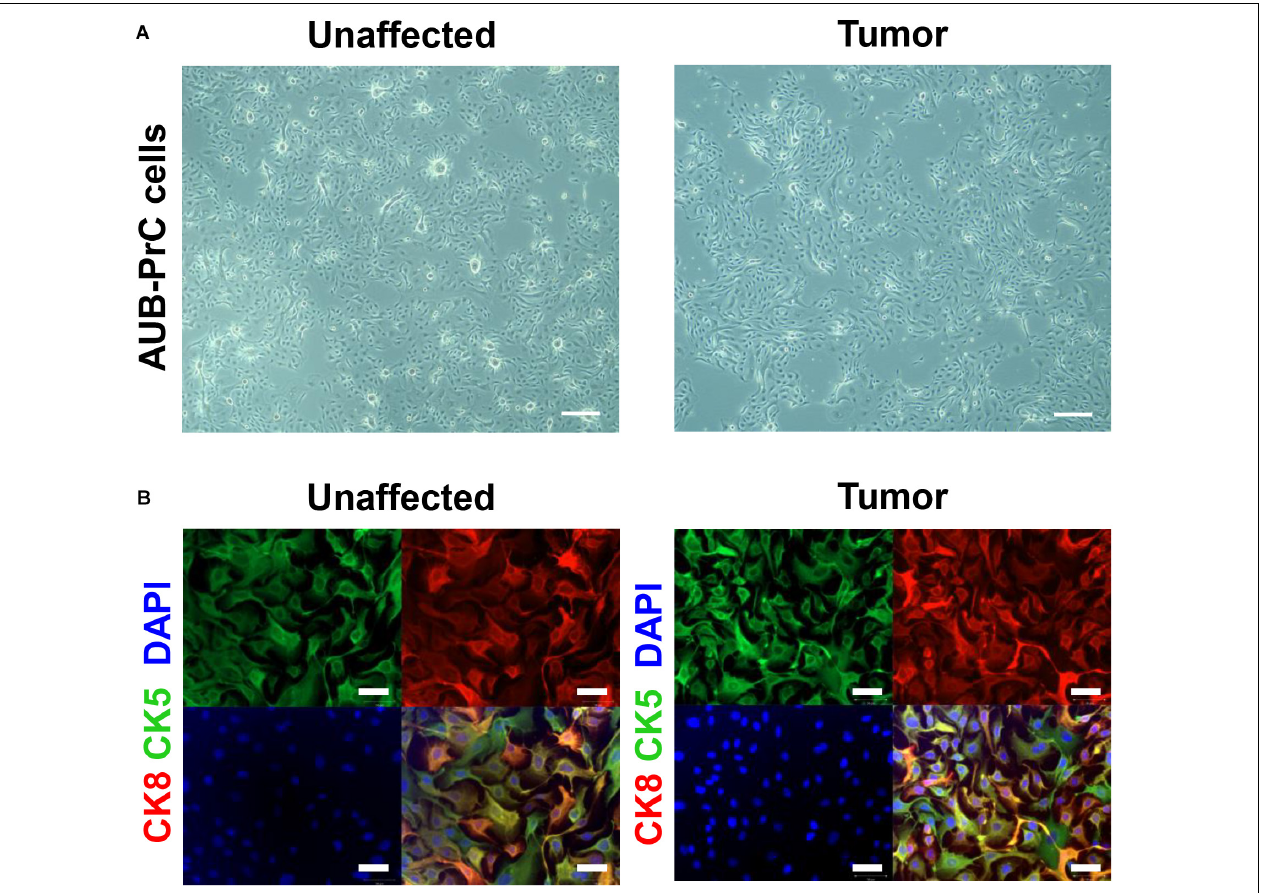
FIGURE 2 | Morphologic and immunofluorescent epithelial lineage characterization of AUB-PrC cells. (A) Representative bright-field images of AUB-PrC cells from unaffected and tumor prostate patient samples {patient 1 with Grade Group 5 [Gleason Score 9(5 + 4)]; patient characteristics in Supplementary Table S1 }, displaying key characteristics of epithelial cells and showing that when cells are far apart from each other, they form extensions that fill the gaps in vitro . Scale bar = 200 µ m. (B) Representative immunofluorescence images of AUB-PrC cells from unaffected and tumor prostate patient samples {patient 3 with Grade Group 2 [Gleason Score 7(3 + 4)]; patient characteristics in Supplementary Table S1 } stained for the lineage epithelial cell markers, CK8 (luminal epithelial cell marker) and CK5 (basal epithelial cell marker), and the nuclear counterstain DAPI illustrating CK8 + /CK5 + intermediate character. Scale bars = 50 µ